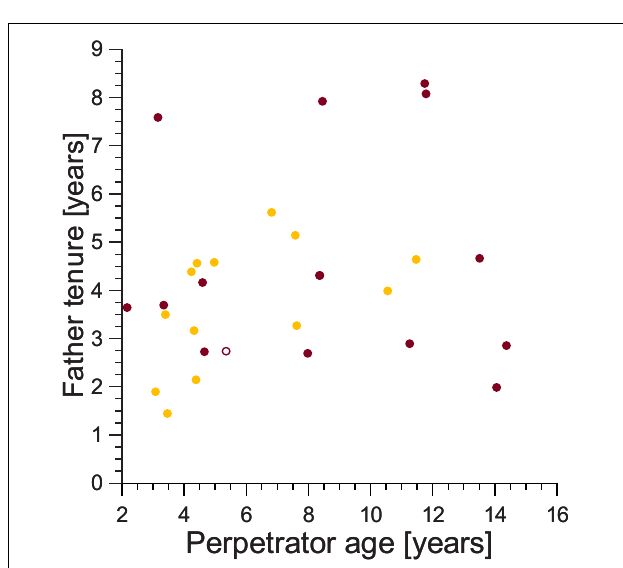
FIGURE 6 | The tenure of the fathers of cubs lost to violent attacks (burgundy) and maternal neglect (amber) on the date when the cub was conceived in relation to the age of the female perpetrator of the violence on the date of cub death (burgundy) or the age of the mother at conception of the victim if the victim died from fatal maternal neglect (amber). Filled symbol: immigrant males, open symbol: natal male.